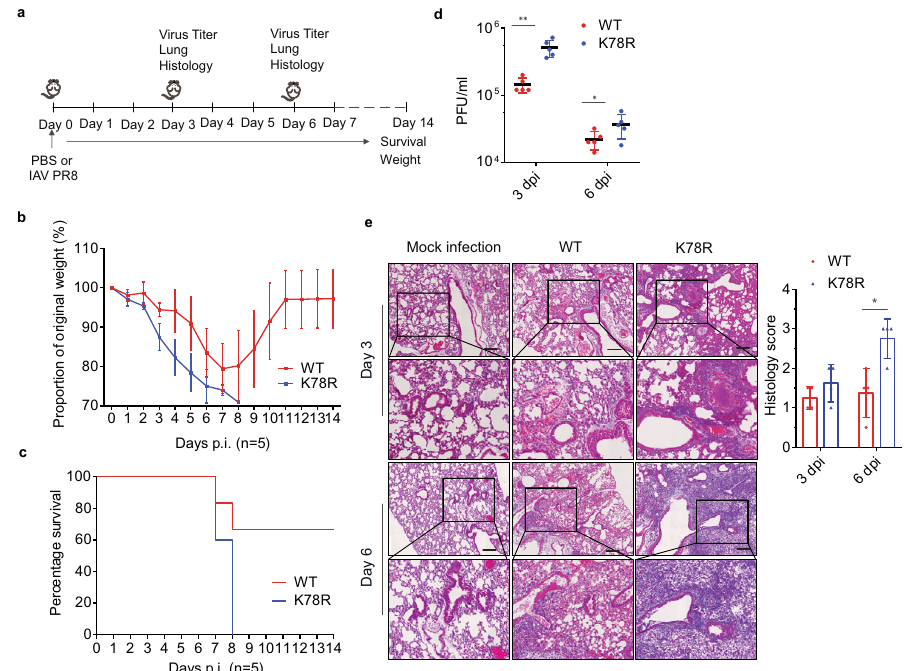
Fig. 7 Replication of WT and the K78R M2 IAVs in mice. Six-week-old male C57Bl/6 mice (15 per group) were infected with PR8 virus (WT) or recombinant virus having the K78R M2 mutant (K78R) (200 PFU) intranasally. Five mice per group were euthanized on days 3 and 6 post infection. Bronchoalveolar lavage fl uids were collected to measure IAV titers. Lungs were harvested for histopathology. Survival of mice ( fi ve per group) was monitored until day 14. a Experimental plan. b Mouse body weight curves ± SD ( n = 5 mice) up to day 14 post infection. c Mouse survival curves for 14 days ( n = 5 mice). d Mean lung virus titer ± SD ( n = 5 mice) on day 3 and 6 post infection. e Mouse lungs were isolated on day 3 and day 6 post infection. H&E staining was performed on lung sections. Scale bar represents 200 μ m. Histological scoring is shown as mean ± SD ( n = 4 mice). * P < 0.01; ** P < 0.001; n.s., nonsigni fi cant; unpaired two-tailed Student ’ s t -test, without any adjustments for multiple